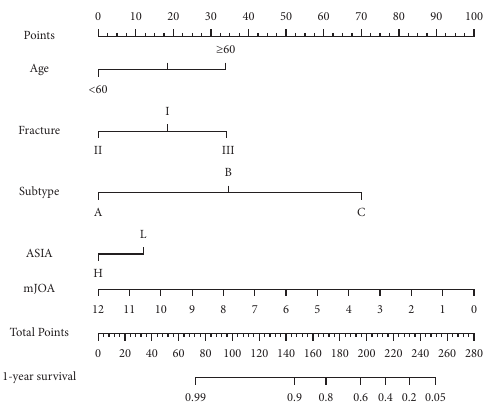
Figure 6: Predictive evaluation nomogram for fracture classifi- cation and clinical evaluation.